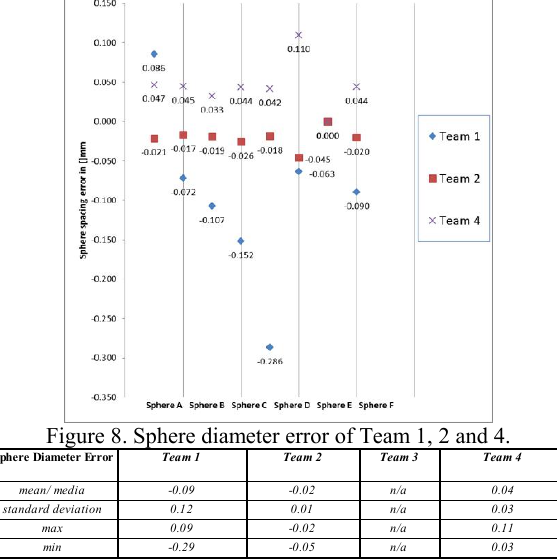
Figure 9. Sphere spacing error for Teams 1-4.